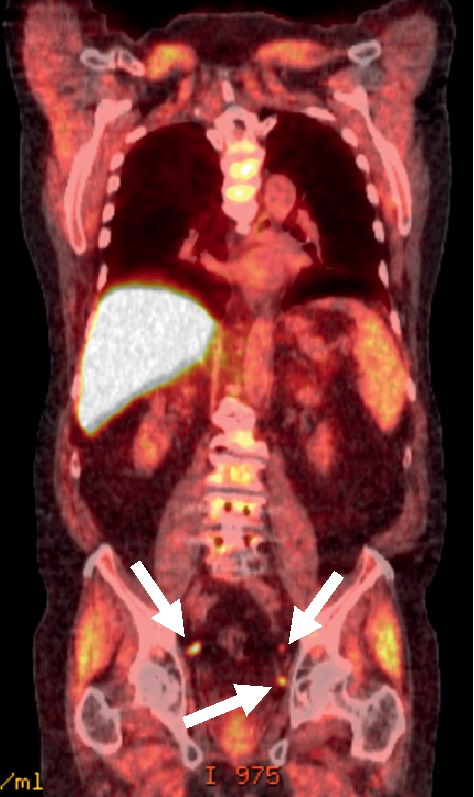
Image of an 81-year-old male who had received proton beam radiation therapy. He was referred for 18F-fluciclovine imaging with PSA rising to 3.3 ng/mL. This coronal, fused PET/CT view shows 3 prostate cancer metastases (white arrows). Note the node superiorly on the right, with very subtle 18F-fluciclovine uptake; this node is ∼3 mm.